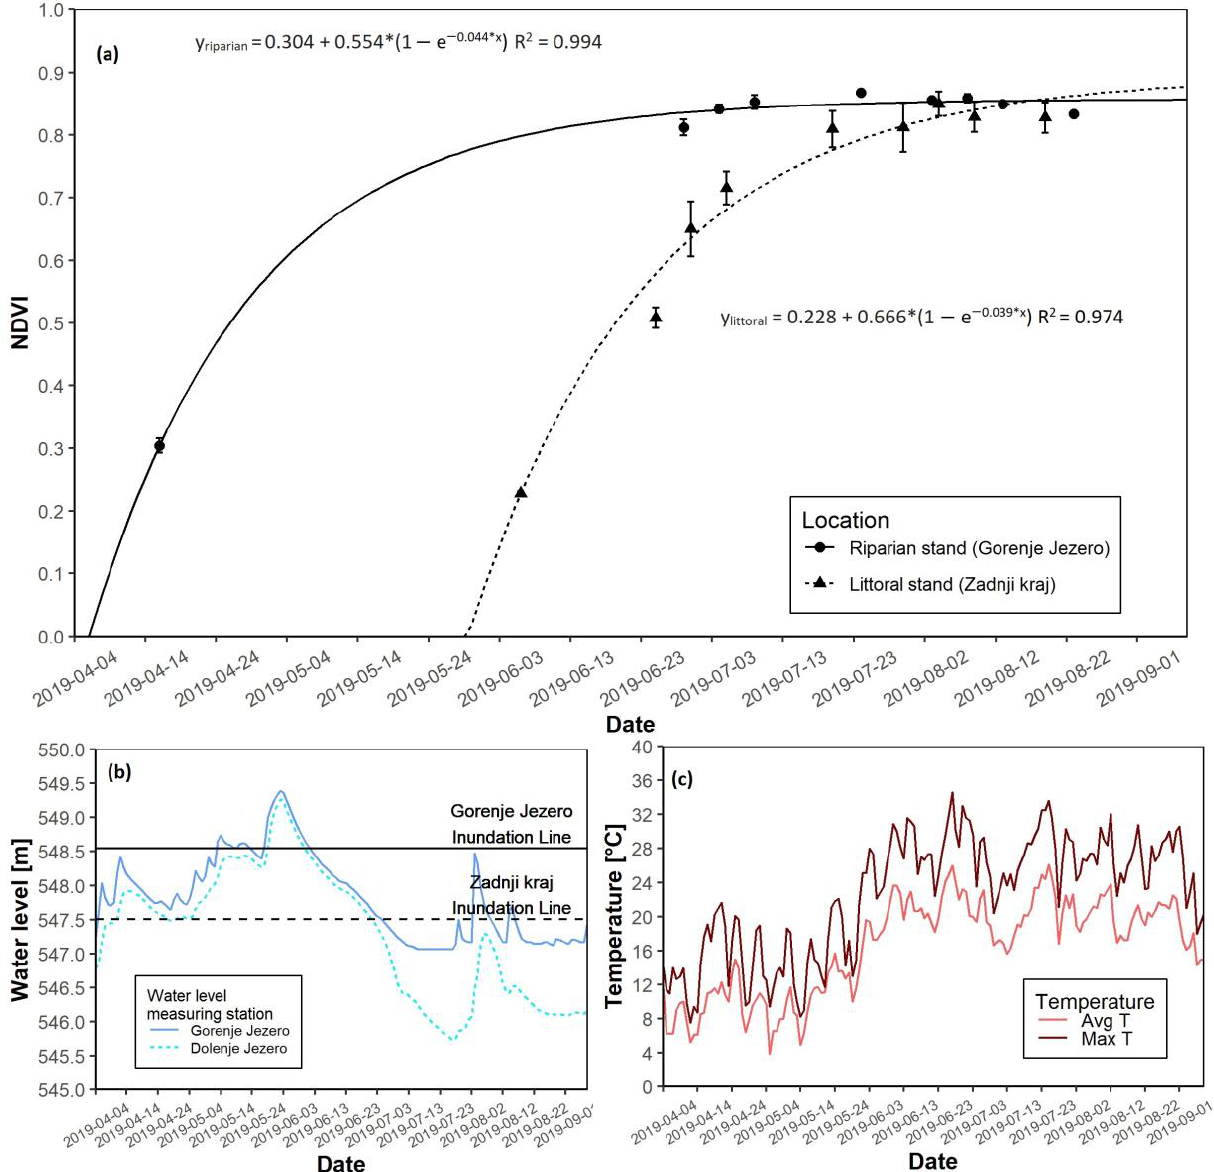
Figure 6. NDVI growth models for both reed sites with water level data for the 2019 growing season. ( a ) NDVI growth models for the riparian and littoral reed stands; ( b ) Water level data for the riparian and littoral reed stands; ( c ) Daily average and maximal temperatures.